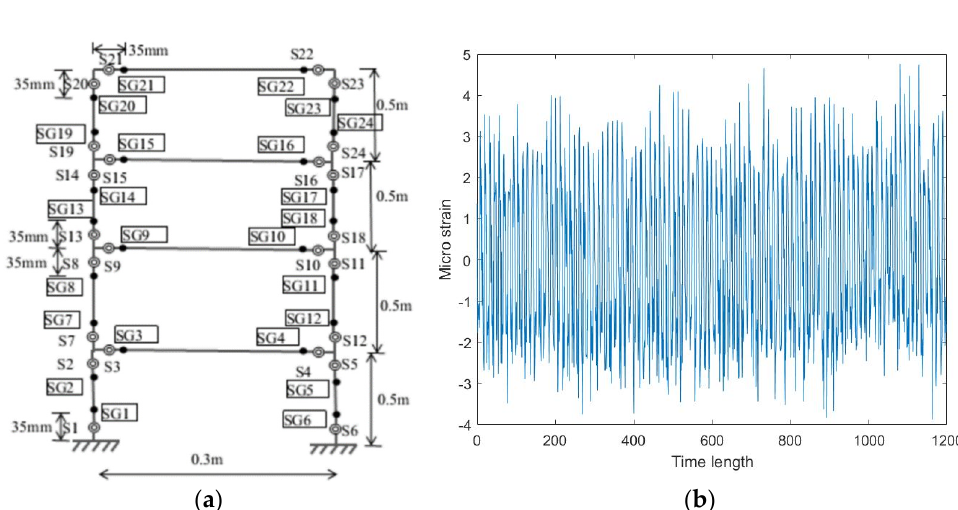
Figure 6. ( a ) Numerical model of four-story planer frame and ( b ) experimental system noise. Table 7. Detailed descriptions of numerical cases.